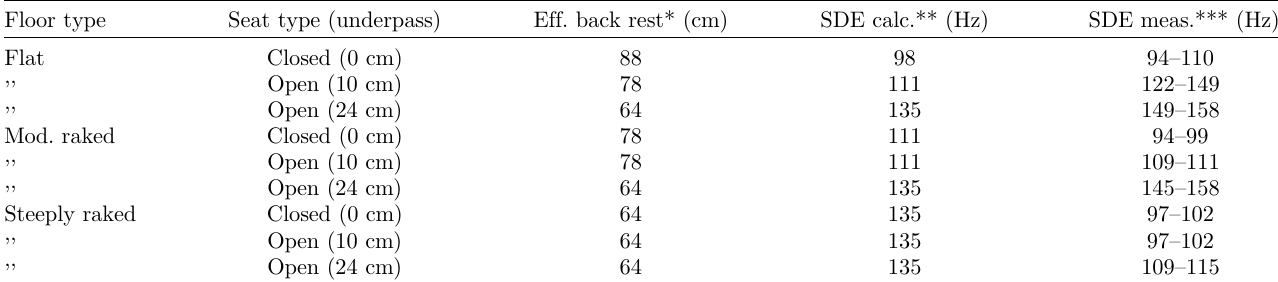
Table 3. The seat and fl oor types with the estimated effective seat back rest heights * (the unobstructed part of the seat back rest) together with the calculated main dip frequencies ** with effective seat backrest corresponding to k /4, as well as the measured main attenuation dip frequencies *** for the fl oor and seat